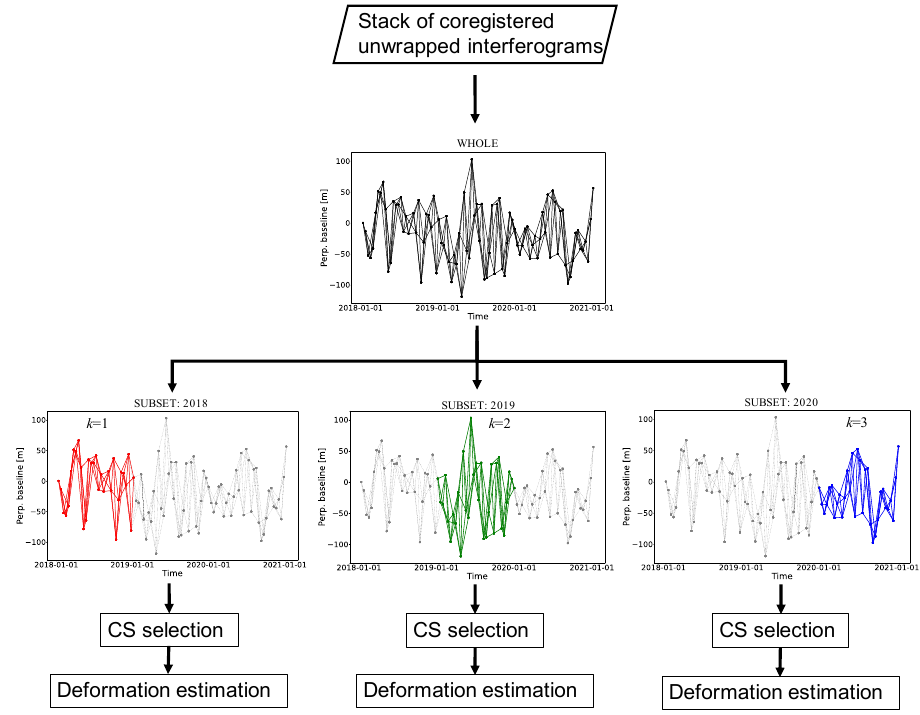
Figure 6. Process flow in the SUBSET method. In this example, the three-year time series SAR dataset is separated into three single-year datasets (2018, 2019, and 2020). The interferograms are formed by SLC images corresponding to each subset through a sequential network. This figure uses the perpendicular baseline and observation date of Frame 3 as an example.